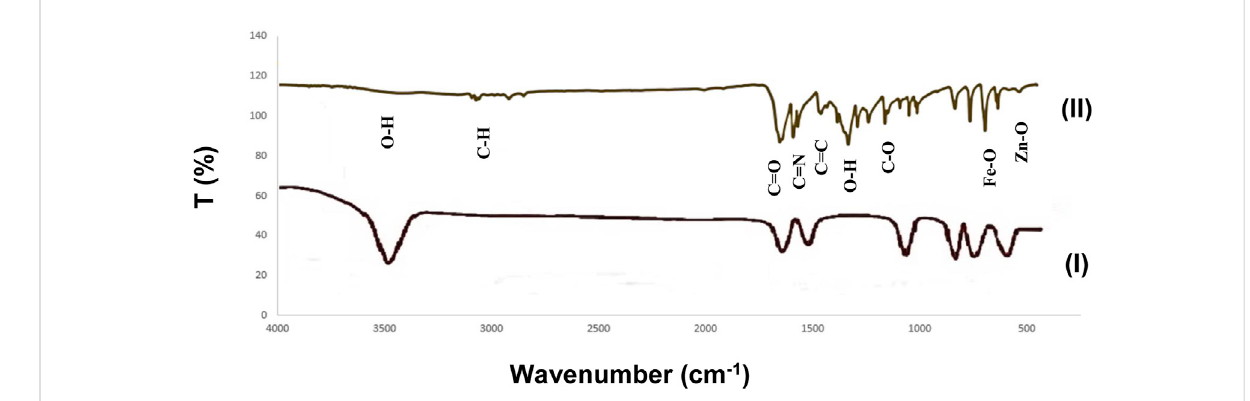
FIGURE 5 FTIR spectrum of Fe 3 O 4 (I) and Fe 3 O 4 /Zn-metal organic framework magnetic nanostructures (II).